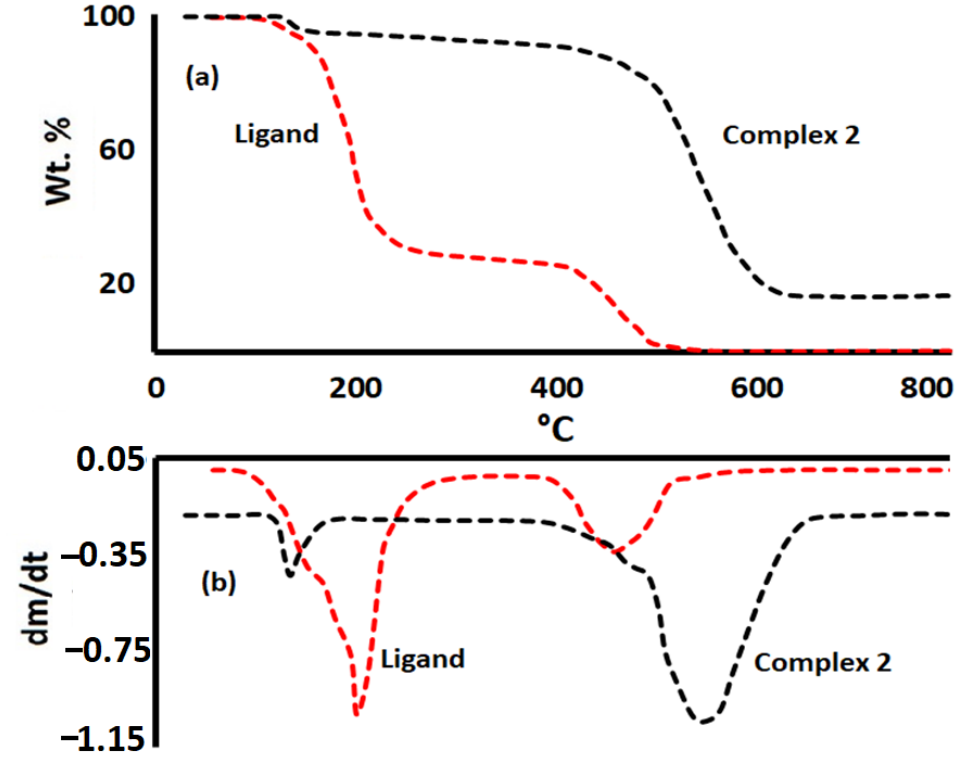
Figure 9. TGA ( a ) and DTG ( b ) of the tetradentate ligand and complex 2 .